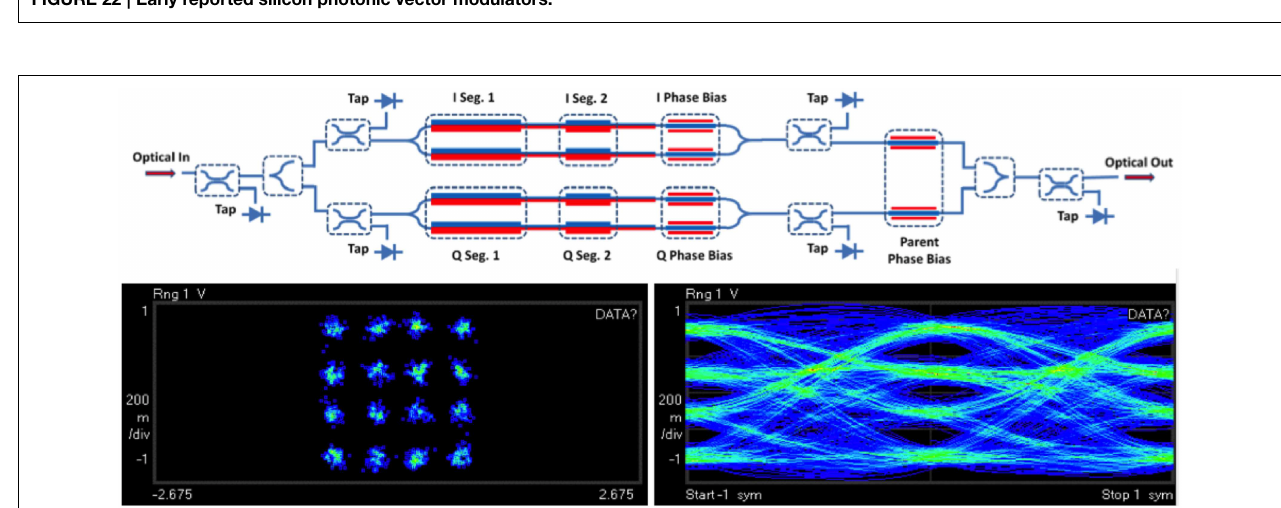
FIGURE 22 | Early reported silicon photonic vector modulators.